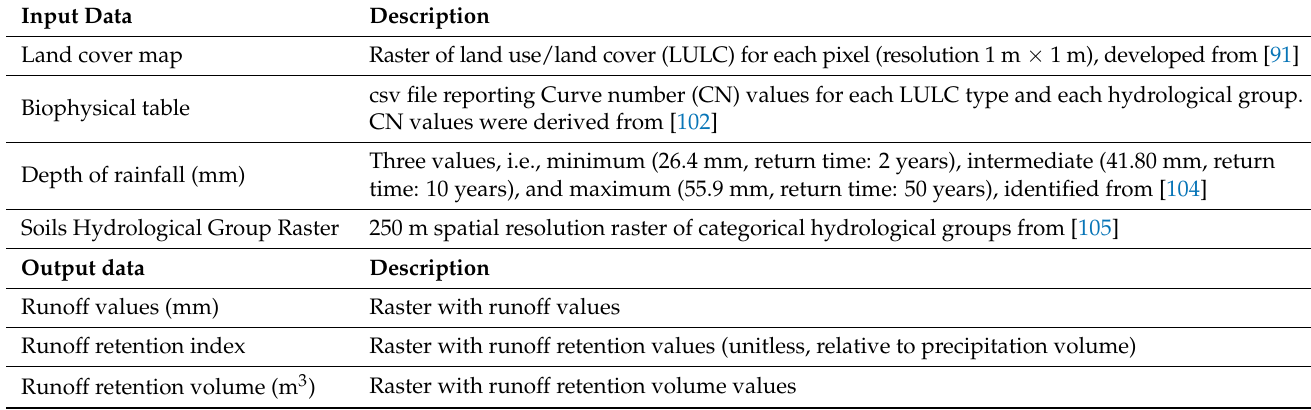
Table 6. Input and output data for the assessment and evaluation of protection against hydrogeologi- cal risks and control of